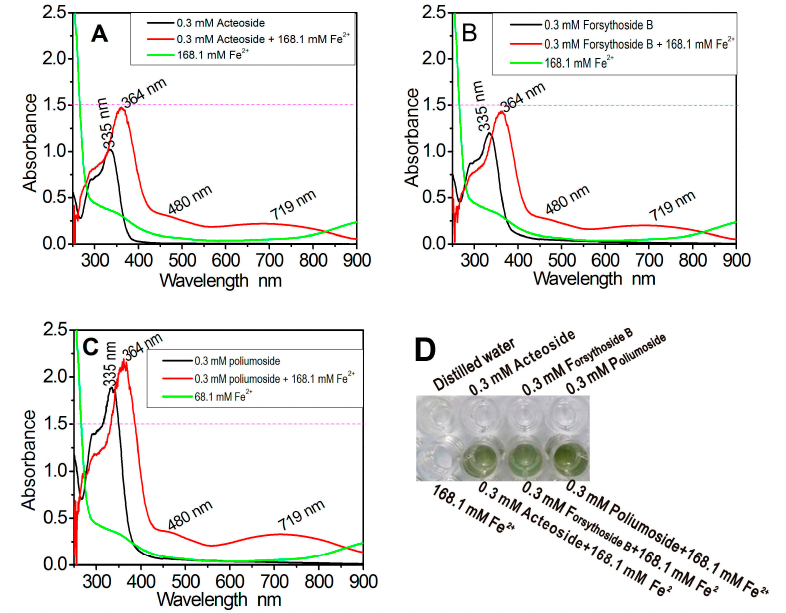
Figure 2. The results of Fe 2+ -chelating reaction of acteoside and its derivatives. ( A ) UV-vis spectra of the reaction mixture of Fe 2+ with acteoside; ( B ) UV-vis spectra of the reaction mixture of Fe 2+ with forsythoside B; ( C ) UV-vis spectra of the reaction mixture of Fe 2+ with poliumoside; ( D ) The solution appearances.